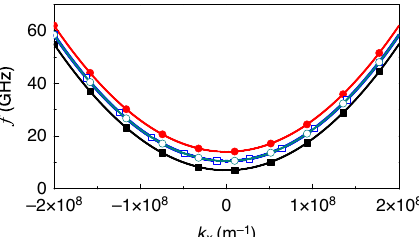
Fig. 2 Magnon dispersion. Merging of the acoustic ( ω J = 0, solid squares) and optical magnon ( ω J = 0, solid circles) modes dispersion Re ½ ω (cid:2)ð k x Þ when approaching the loss/gain-balance (exceptional) point ω J = κ (open